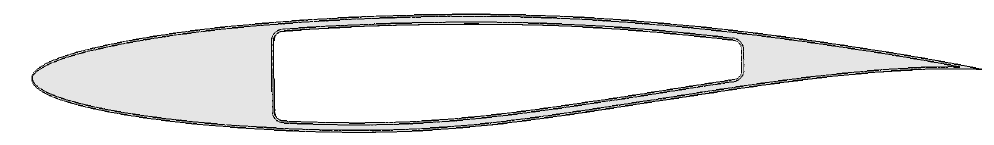
Figure 8. Graphical representation of the RAE2822 case of study complemented with the airfoil and wing-box